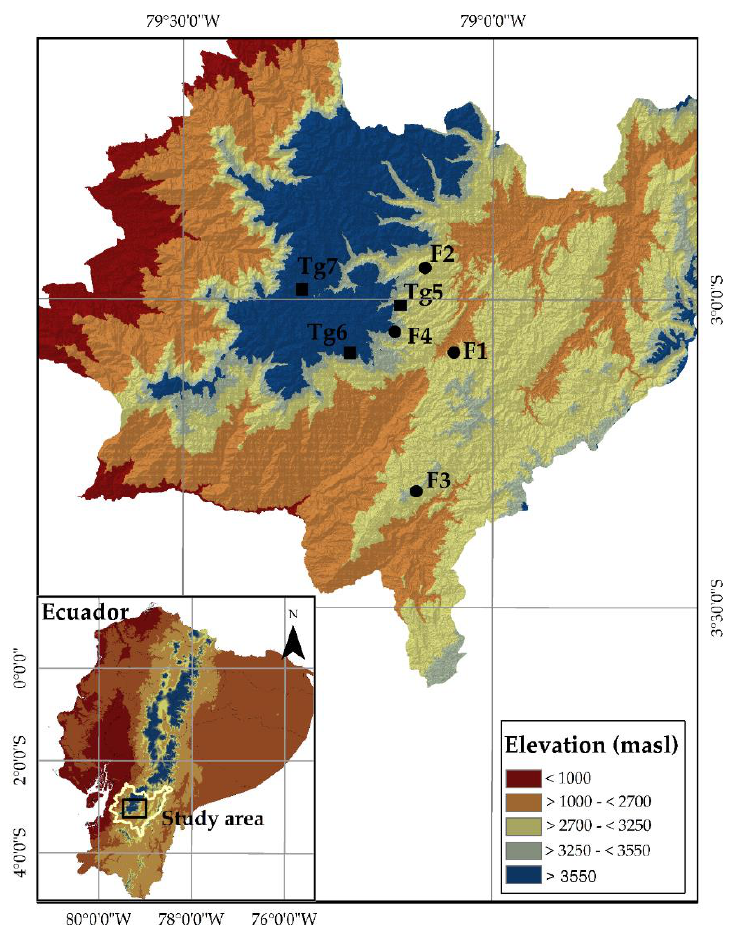
Figure 1. Study area and sampling sites in Azuay province, southern Ecuador. F = High montane forest; Tg = Páramo. 108